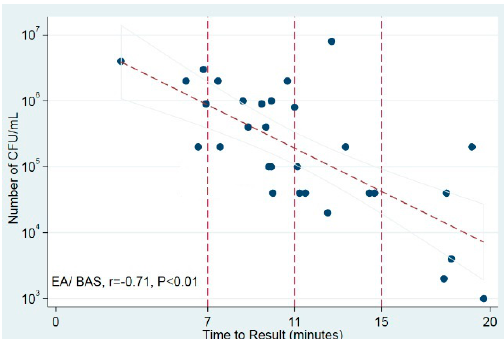
Figure 2. Correlation of time to positivity and bacterial load in culture. Scatter plot shows time to result (in minutes) against number of CFU/mL (log10). Trend line displays best fit of all data points and the 95% CI for the prediction. Vertical reference lines indicate time points. BAS/EA: bronchoaspirate/endotracheal aspirate.